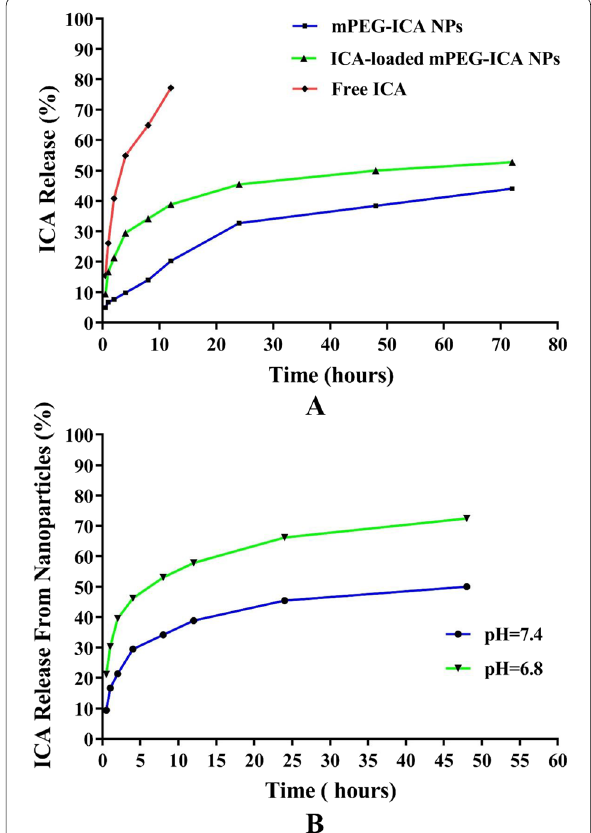
Fig. 4 A ICA release from ICA-loaded mPEG-ICA NPs in PBS at pH 7.4. B ICA release from ICA-loaded mPEG-ICA NPs in PBS at pH 7.4 and